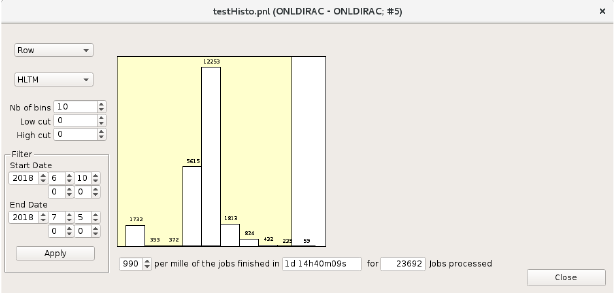
Figure 4. Number of jobs and their average duration ran on the HLTM servers during o ffl ine simulation.